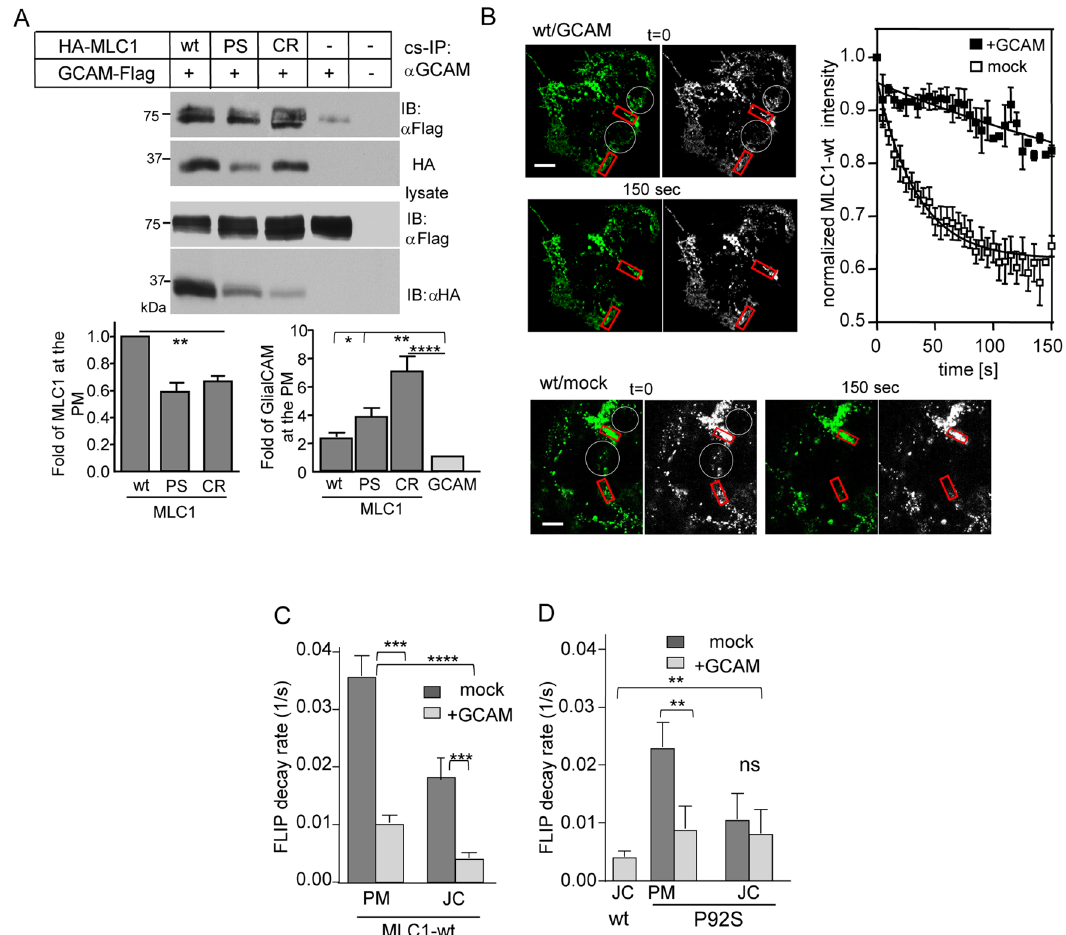
Figure 3. GlialCAM is a diffusional phase barrier for the MLC1 signalling cluster at the PM. ( A ) The indicated HA-MLC1 variants (wt, P92S (PS), C326R CR) interacting with GlialCAM (GCAM) were isolated from the PM using cs-IP with anti-GCAM Ab. The precipitates were analyzed using Western blot analysis with anti-HA or anti-Flag Abs. MLC1 was measured as fold change to wt (left panel) from co-IP-ed samples and the amount of GCAM pulldown was normalized to sample lacking MLC1 (right panel) in HeLa cells. ( B ) MLC1 lateral diffusion at the PM was measured by FLIP. Indicated areas (white circles) were photobleached and the fluorescence loss was monitored in the adjacent red squares. The normalized intensity traces show fluorescence decay in cells + /− GCAM overexpression. ( C , D ) Summary of decay rate constants are expressed as 1/s for MLC1-wt ( C ) and P92S ( D ) in cells + /− GCAM overexpression. GCAM substantially restricts the diffusion of MLC1-wt at the free PM (PM) and cell–cell junctions (JC), in contrast to P92S showing restriction only at the free PM. Statistical analysis against mock (J-D) or wt in the junction (D) are indicated. Means ± SEM, n ≥ 3, **p < 0.01, ***p < 0.001, ****p < Fig. S2A, see also Fig. 3A). GlialCAM overexpression marginally altered the PM stability and internalization of MLC1 variants (Fig. 2C, Fig. S2B). This suggests that the endogenous adhesion molecule expression is sufficient to support MLC1-wt expression into the cluster. Nevertheless, GlialCAM accelerated the endosomal recycling of MLC1-P92S and C326R without impact on wt (Fig. 2D). Similarly, severe MLC1-C326R increased the PM density and endosomal recycling of GlialCAM (Fig. S2C,D). The disease-causing R92W mutation in the N-terminal extracellular IgV-domain of GlialCAM 18 reduced the PM expression and stability of GlialCAM (Fig. 2E,F), reminiscent of the MLC1 mutants cellular phenotype. In contrast, the expression of MLC1-P92S or C326R significantly impeded the internalization rate of GlialCAM (Fig. 2G), which led to a marginal change in the PM stability of GlialCAM (Fig. 2H). Importantly, the PM sta- bilities of endogenous and overexpressed GlialCAM were comparable (Fig. 2H). Jointly, these results suggest that GlialCAM cannot suppress the accelerated internalization of MLC1 disease variants and ~ 3-fold faster PM turnover persisted upon GlialCAM overexpression (Fig. 2C). GlialCAM regulates the lateral PM mobility of MLC1. Coupled endosomal recycling dynamics between GlialCAM and MLC1 (Figs. 1E, 2D) implies that GlialCAM expression level may determine the mem- brane phase-separation of the PM signalling cluster, acknowledged as a regulator of the transmembrane adhe-